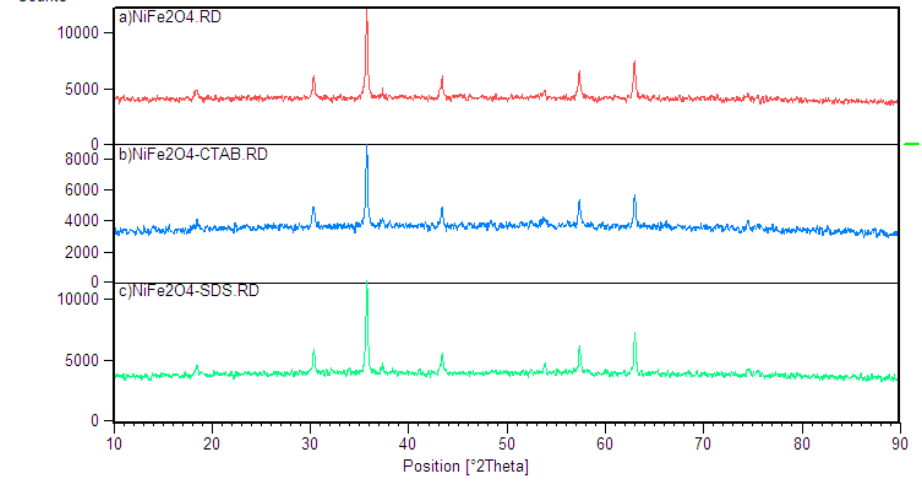
Fig. 2. XRD patterns of NiFe